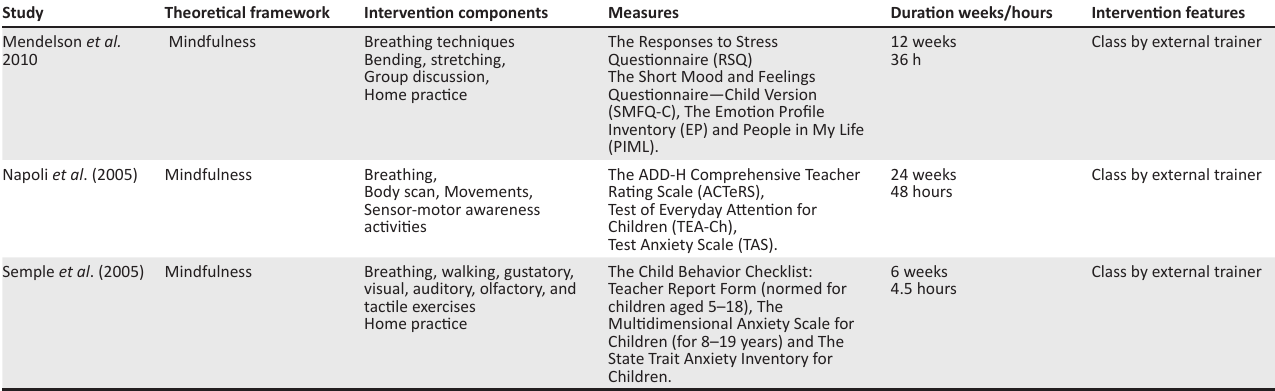
TABLE 2 (Continues...): General features of the